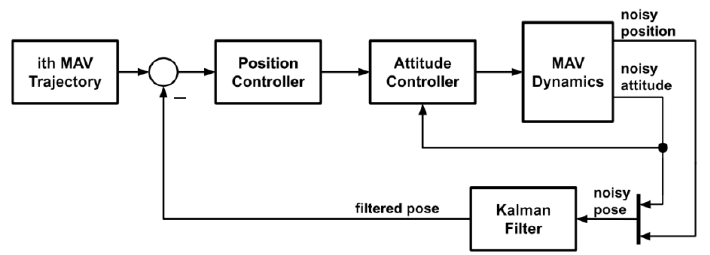
Figure 8. Control cascade loop structure. The attitude controller runs at a higher frequency than the position controller.